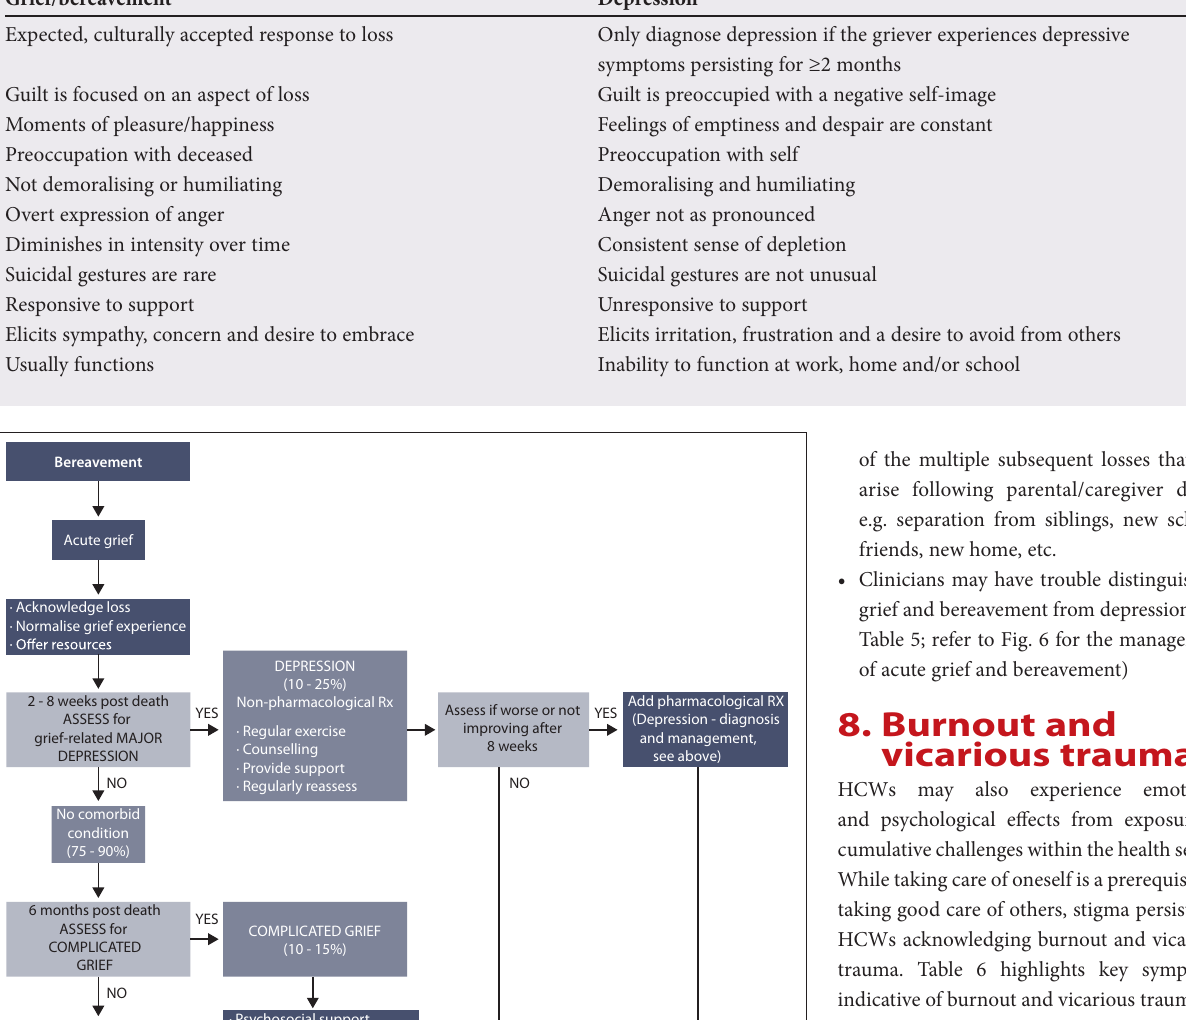
Table 5. Differentiating grief/bereavement from depression [25] Grief/bereavement Depression